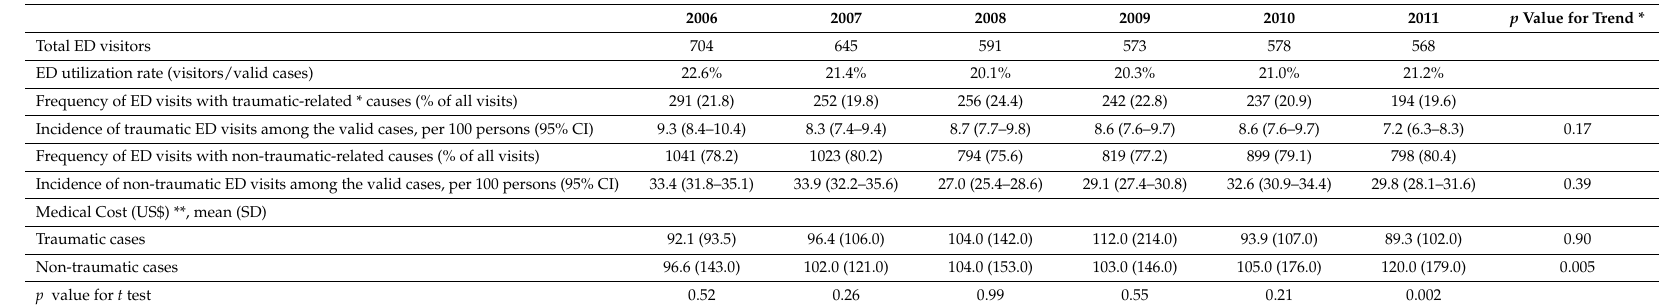
Table 3. Trends in and comparisons of emergency department (ED) utilization in the studied